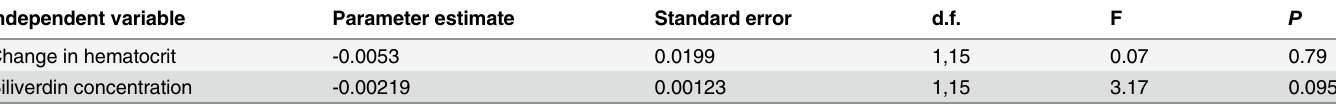
Table 3. Log of Spleen-Somatic Index (SSI) was not significantly predicted by change in hematocrit over the duration of the experiment or in bili- verdin concentration in the